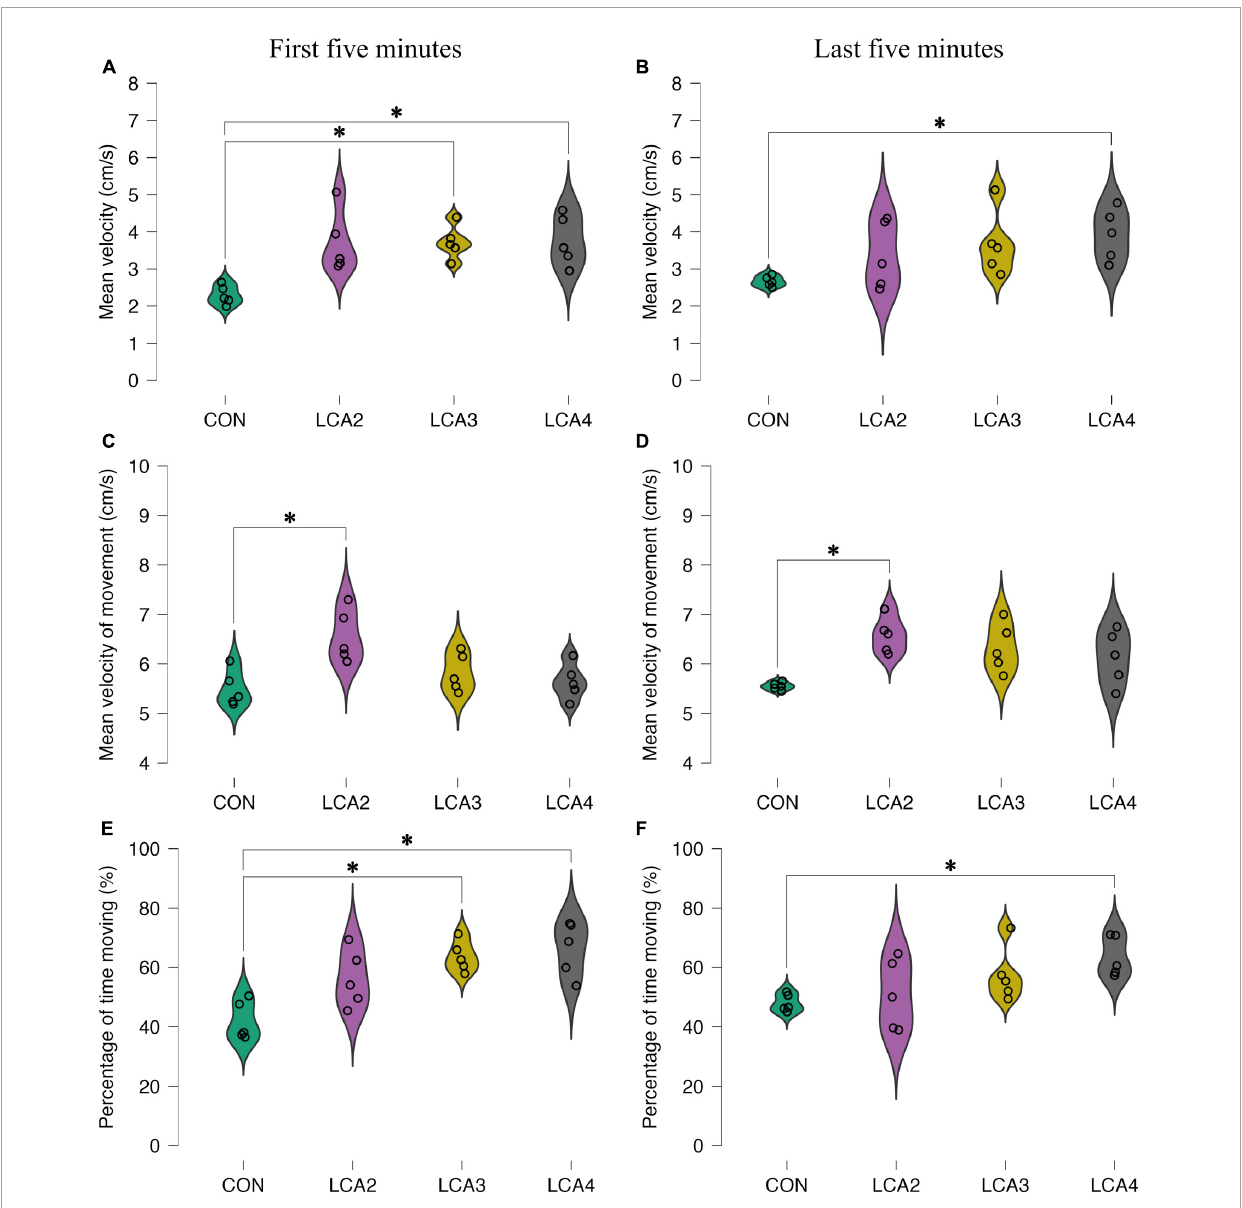
FIGURE5 The results of the motility parameters in the dark compartment. (A,B) The distance moved relative to the time spent in the dark compartment. (A) Group means: CON = 2.3 cm/s [95% CI (2.1, 2.5)], LCA2 = 3.7 cm/s [95% CI (3.0, 4.4)], LCA3 = 3.7 cm/s [95% CI (3.3, 4.1)], LCA4 = 3.8 cm/s [95% CI (3.2, 4.4)]. (B) Group means: CON = 2.7 cm/s [95% CI (2.5, 2.8)], LCA2 = 3.4 cm/s [95% CI (2.6, 4.2)], LCA3 = 3.7 cm/s [95% CI (2.9, 4.4)], LCA4 = 3.9 cm/s [95% CI (3.3, 4.5)]. (C,D) The distance moved relative to time spent moving in a the dark compartment. (C) Group means: CON = 5.5 cm/s [95% CI (5.2, 5.8)], LCA2 = 6.6 cm/s [95% CI (6.1, 7.0)], LCA3 = 5.8 cm/s [95% CI (5.3, 6.0)], LCA4 = 5.6 cm/s [95% CI (5.3, 6.0)]. (D) Group means: CON = 5.6 cm/s [95% CI (5.5, 5.6)], LCA2 = 6.6 cm/s [95% CI (6.3, 6.9)], LCA3 = 6.3 cm/s [95% CI (5.9, 6.8)], LCA4 = 6.1 cm/s [95%